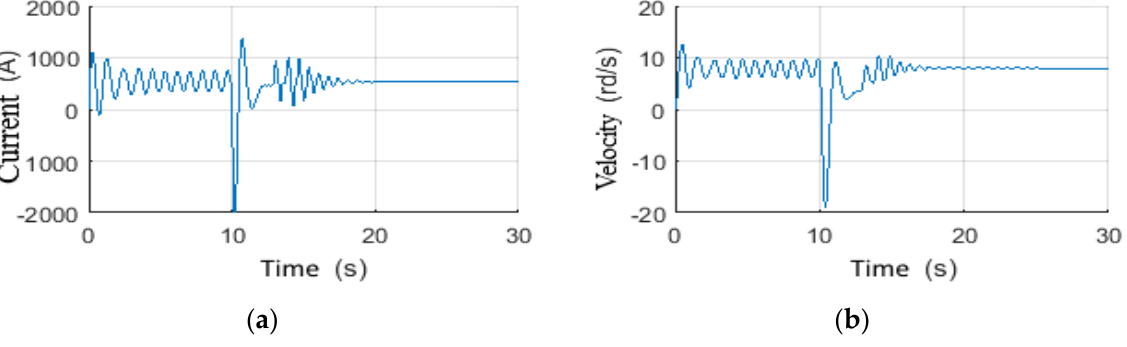
Figure 32. Observer-based controller responses for Scenario-9: ( a ) Velocity, ( b ) Voltage.